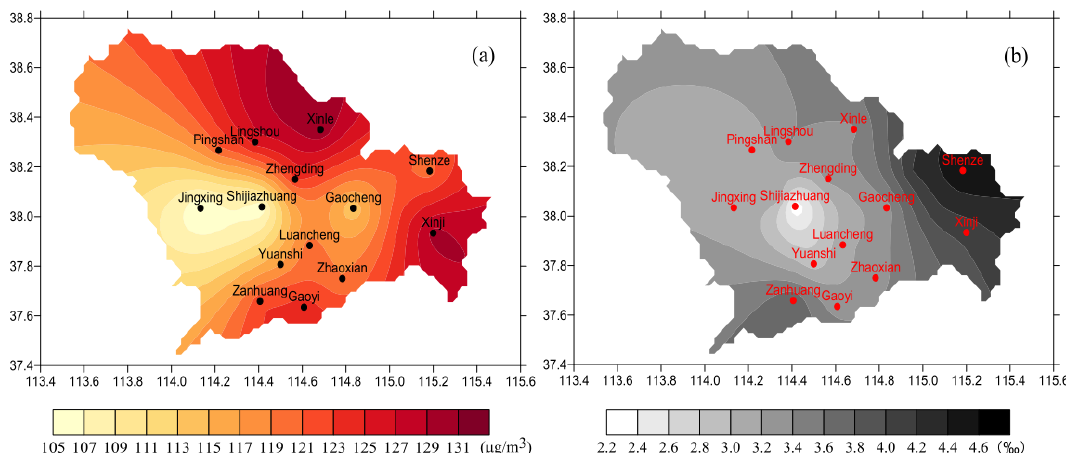
Figure 2. Distribution of the average PM 2.5 concentration ( a ) and circulatory deaths ( b ) in Shijiazhuang